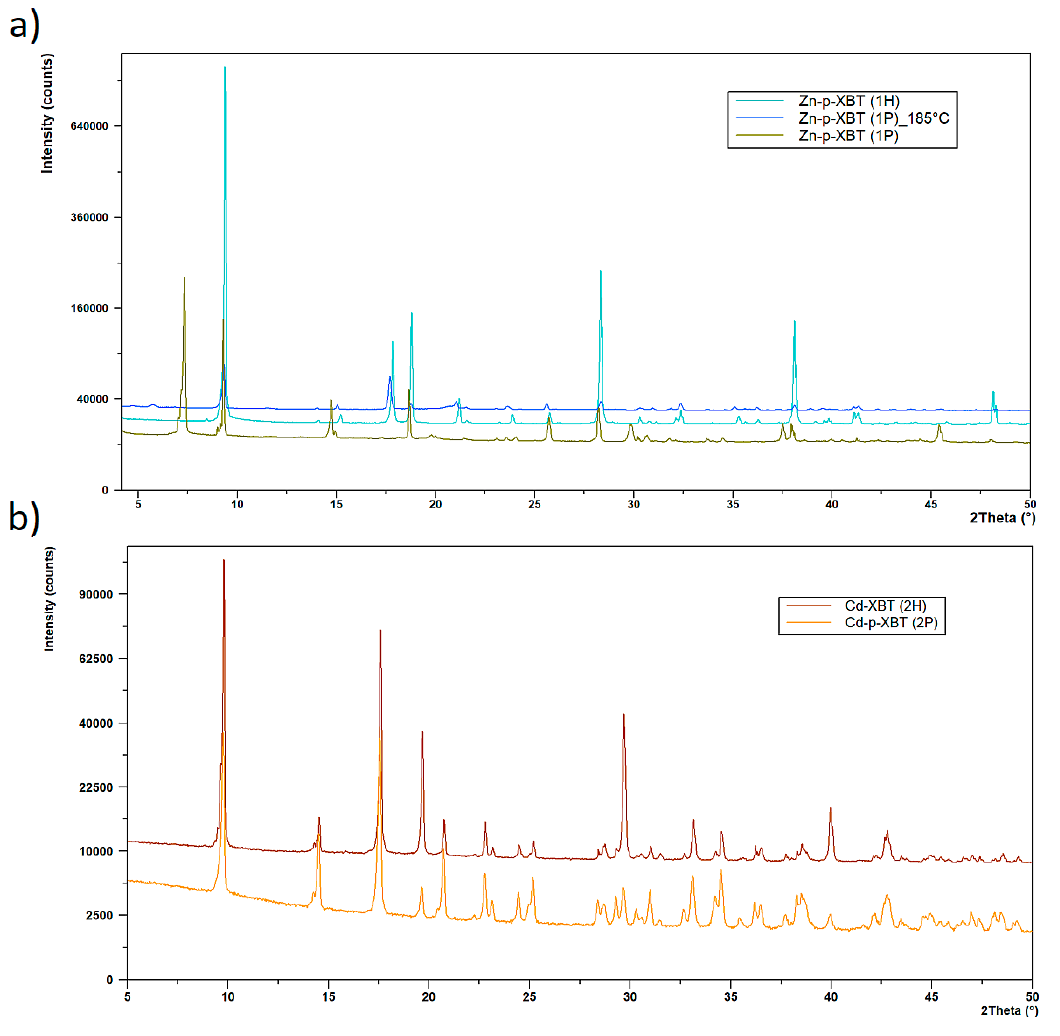
Figure 4. PXRD patterns: ( a ) 1H and 1P at 25 °C, and 1P after heating to 185 °C; ( b ) 2H and 2P at 25 °C.